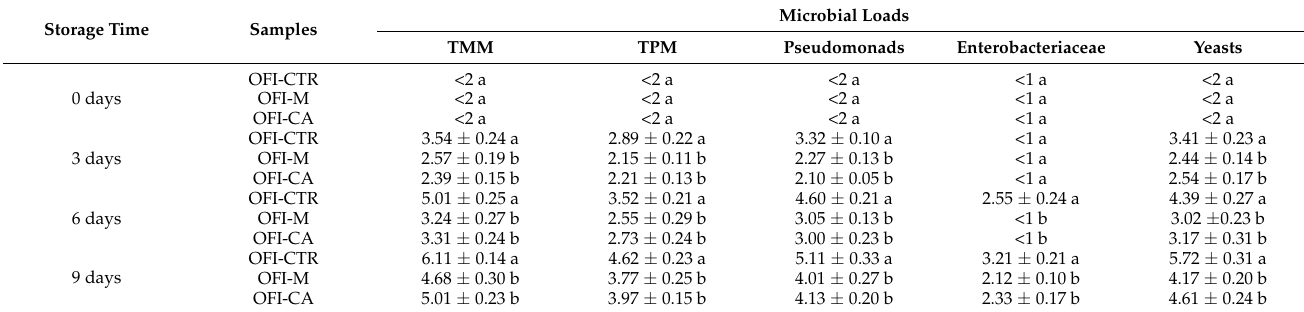
Table 3. Microbial loads of minimally processed O. ficus-indica fruits non-treated (OFI-CTR) and treated with mucilage (OFI-M) and calcium ascorbate coating (OFI-CA) during cold storage (9 days at 5 ◦